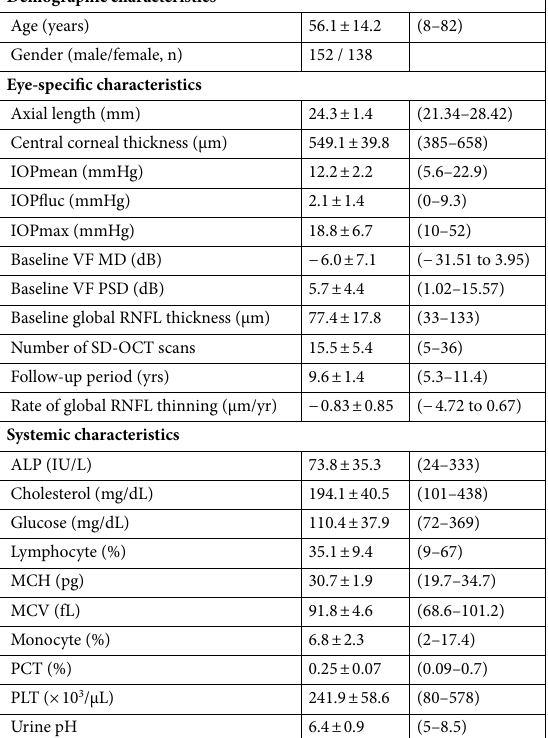
Table 1. Clinical characteristics of patients. Values are shown in mean ± standard deviation (range) unless otherwise indicated. IOP intraocular pressure, IOPmean mean IOP, IOPfluc IOP fluctuation,